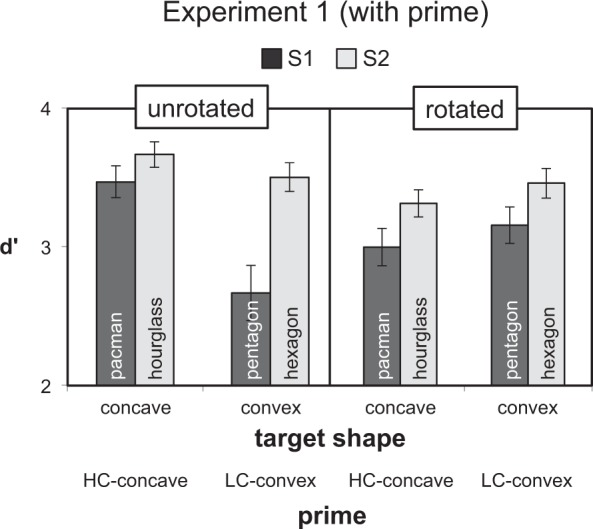
Experiment 1. Mean d′ values (± 1 sem) in the
reduced within-subjects Rotation × CCP × Symmetry design.